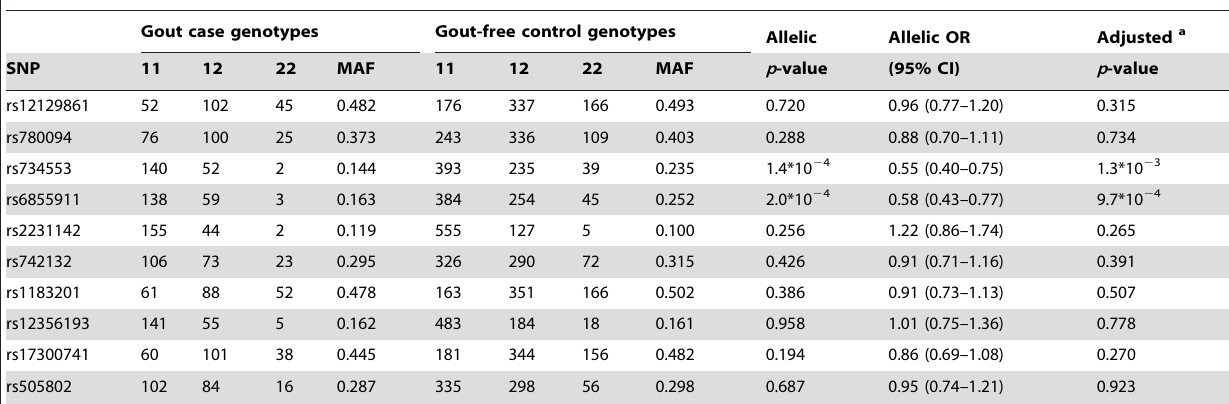
Table 6. Association analysis results in female gout case-control